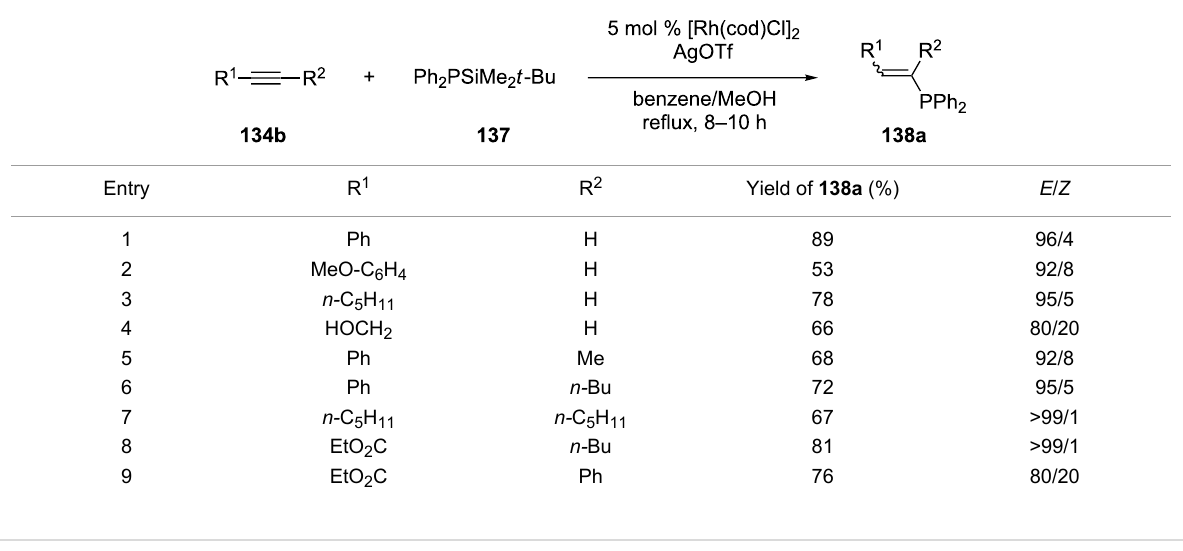
Table 15: Rhodium-catalyzed hydrophosphination of alkynes 134b with a silylphosphine 137 (cod = 1,5-cyclooctadiene).